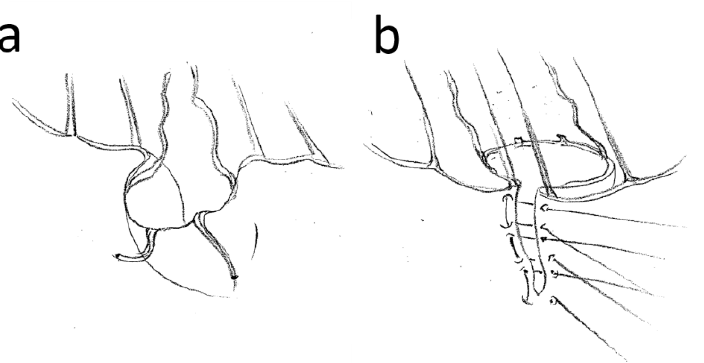
Figure 2. PML repair with the transverse plication technique. Detailed view of the protruding area ( a ) and the corrective measures, including the definition of the leaflet areas with the chordae still intact, the reversal of the prolapse and the closure suture technique ( b ). Note the resected chordae stumps and the extended chordae, which were left intact.